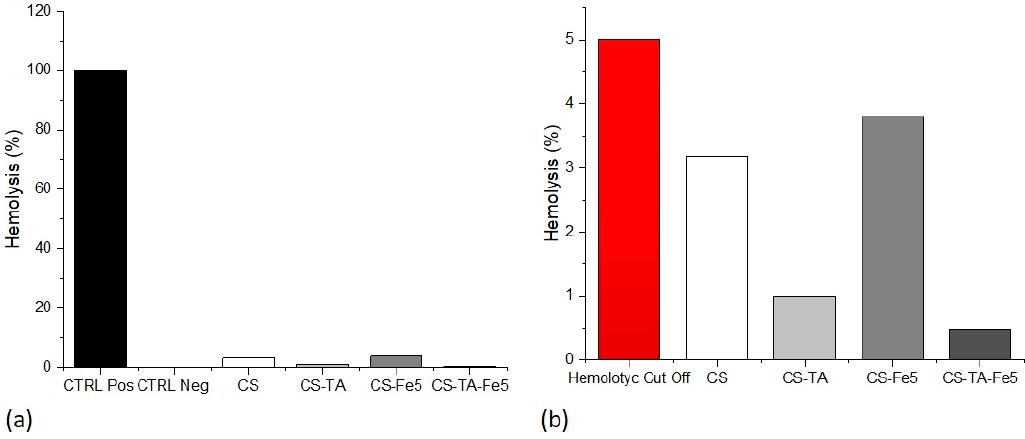
Figure 7. Hemolysis test results: ( a ) results of the hemolysis test performed on different chitosan films compared to positive control (CTRL Pos) and negative control (CTRL Neg) conditions.; ( b ) results obtained from the previously described experimental conditions compared to the cut-off level of 5% hemolysis.